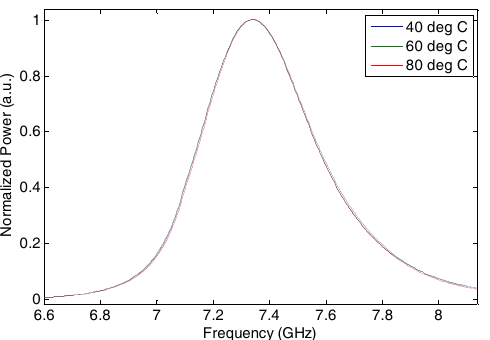
Figure 7. MWP filter response for Sensor 1 which is held at constant (room) temperature, while the temperature of Sensor 2 is varied 40 °C to 80 °C (after Reference [12]).